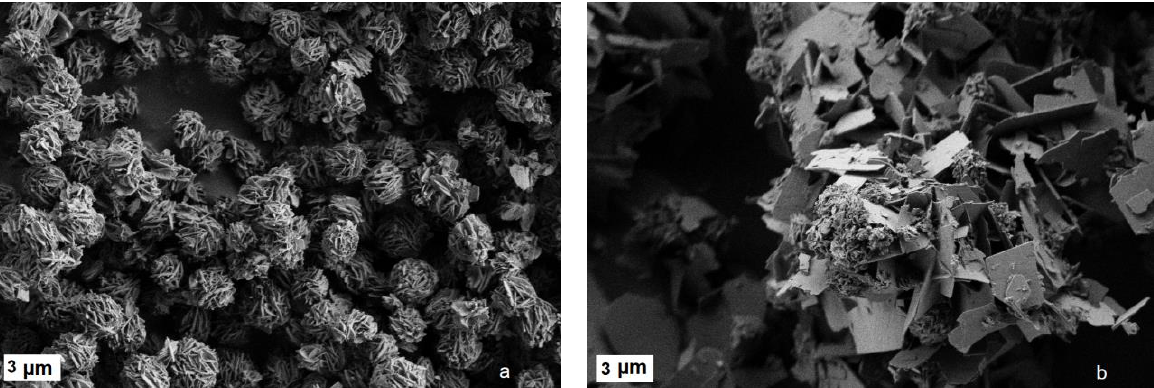
Figure 3. SEM data for ( a ) the (Gd 0.59 Eu 0.41 ) 2 (OH) 5 Cl· n H 2 O sample and ( b ) its reaction product with an aqueous solution of potassium 4-sulfobenzoate at 120 °C after 24